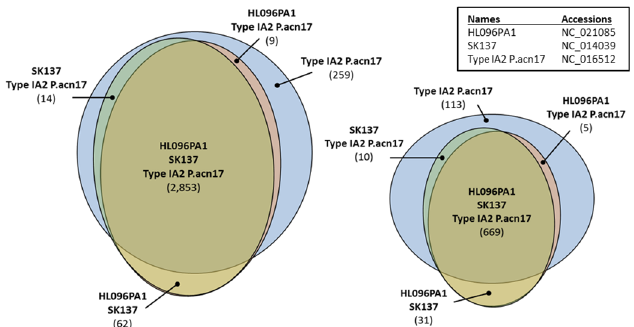
Fig 2. Comparison of unique sequences and subsequences for RPMI 8226. Venn diagrams showing the difference between the number of unique 32-base long subsequences (left) and 80-base long sequences (right) from leukemia RPMI 8226 cell line sample that mapped to (with perfect match) and shared by three reference P. acnes genomes (HL096PA1, SK137, and Type IA2 P.acn17).